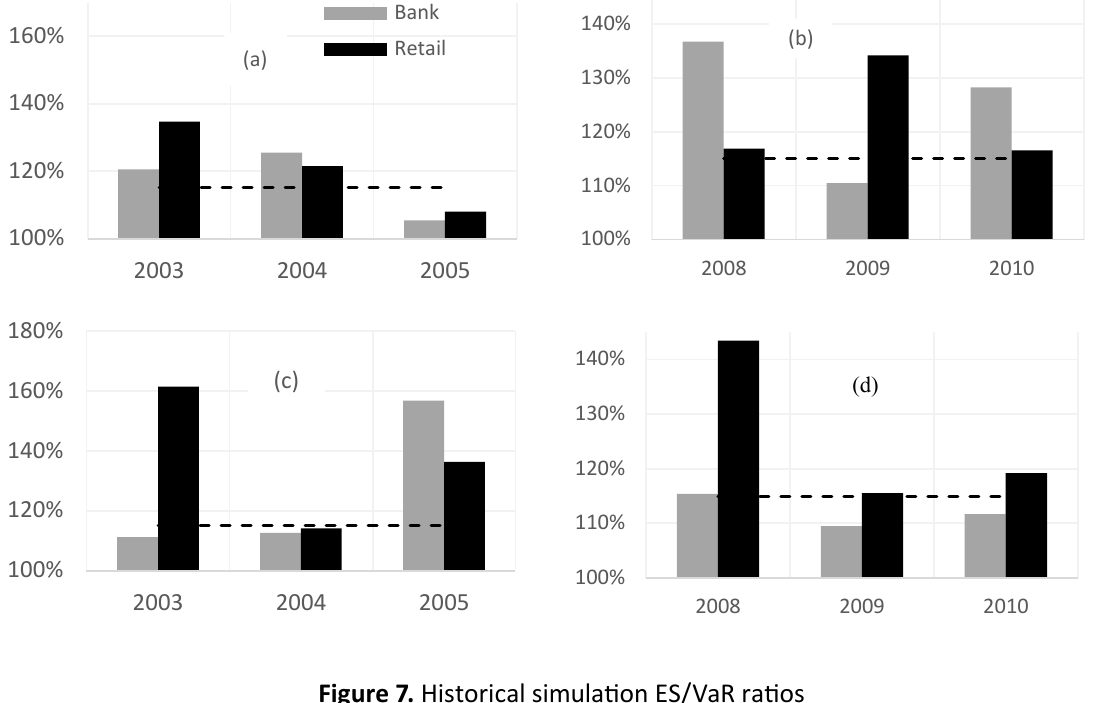
Figure 7. Historical simulation ES/VaR ratios for (a) SA 03-05, (b) SA 08-10, (c) UK 03-05 and (d) UK 08-10